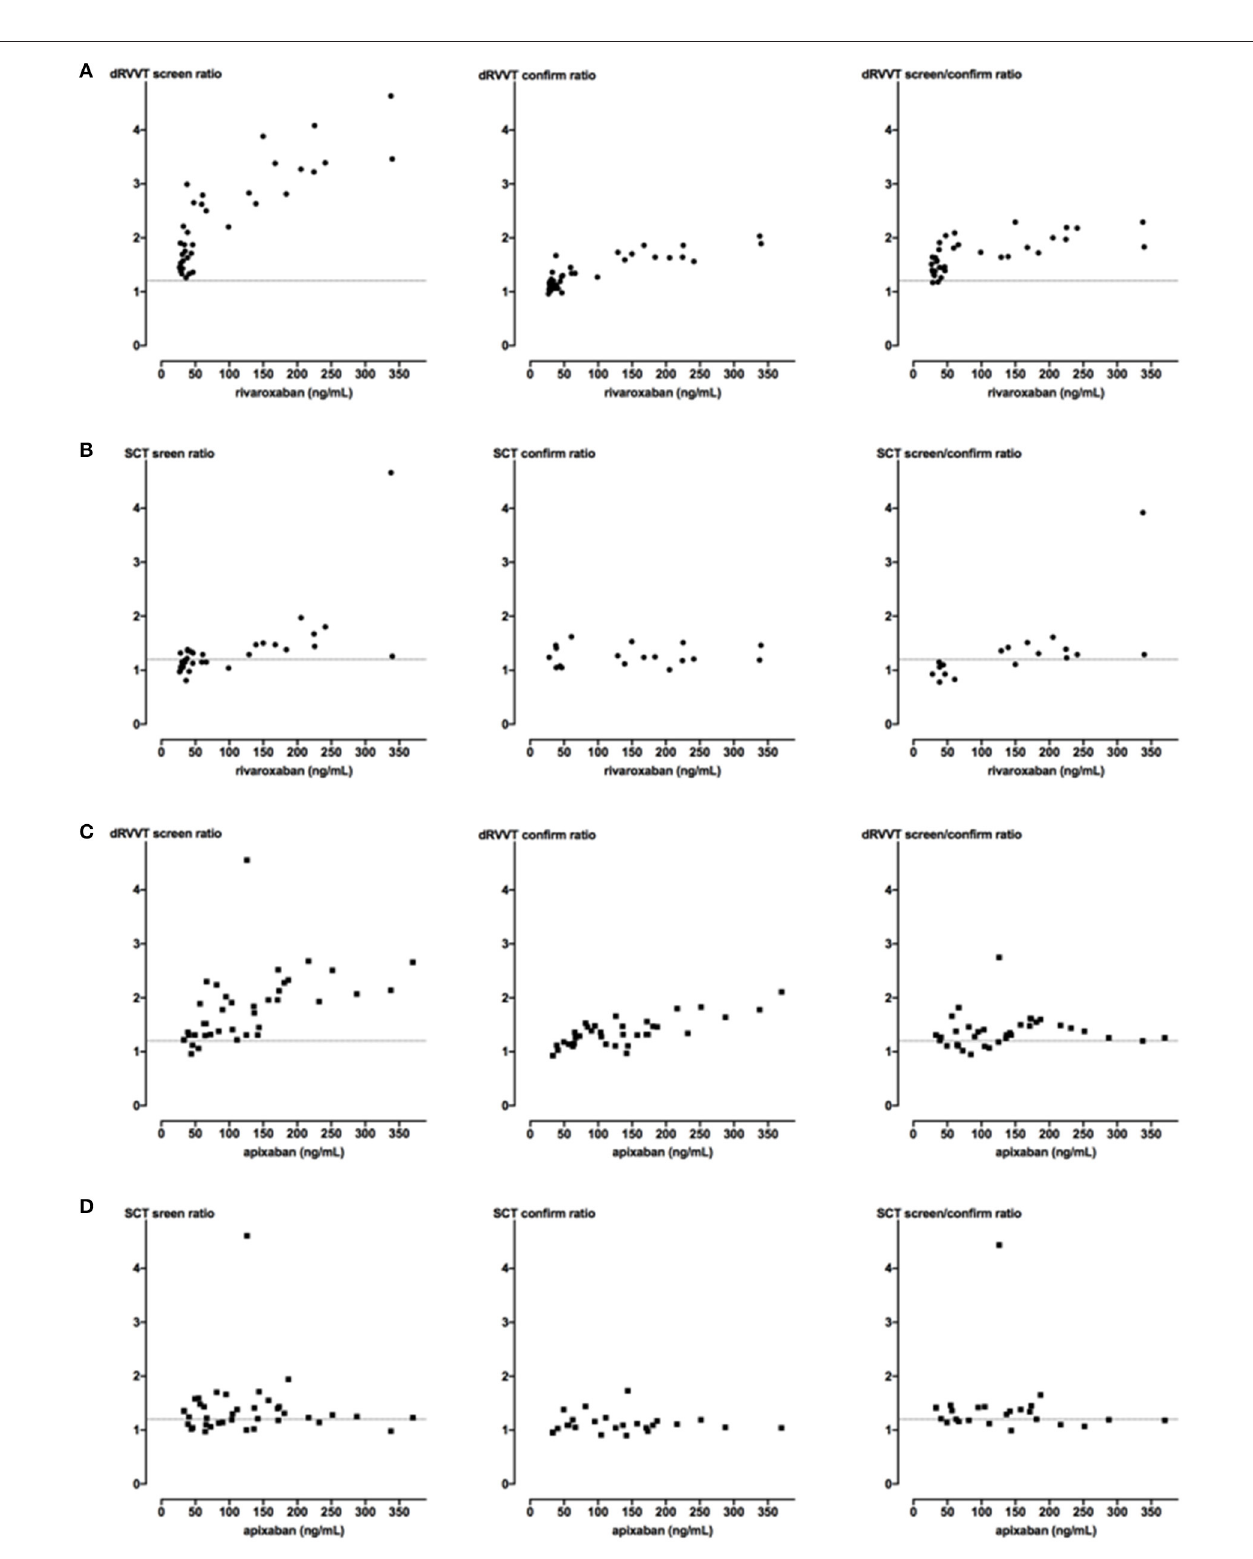
FIGURE 2 | Impact of FXa inhibitors on dRVVT and SCT assays. Samples from patients receiving direct oral FXa inhibitors were tested using dRVVT ( n = 38 in A and n = 39 in C) and SCT ( n = 36 in B and n = 39 in D) screen assays. Only samples having elevated screen ratio (i.e., ≥ 1.20) were subsequently analyzed using confirm assays. Screen and confirm ratios are plotted as a function of rivaroxaban (A,B) or apixaban (C,D) plasma concentrations measured using specific anti-Xa assays. Dashed line corresponds to the cutoff value of 1.20.